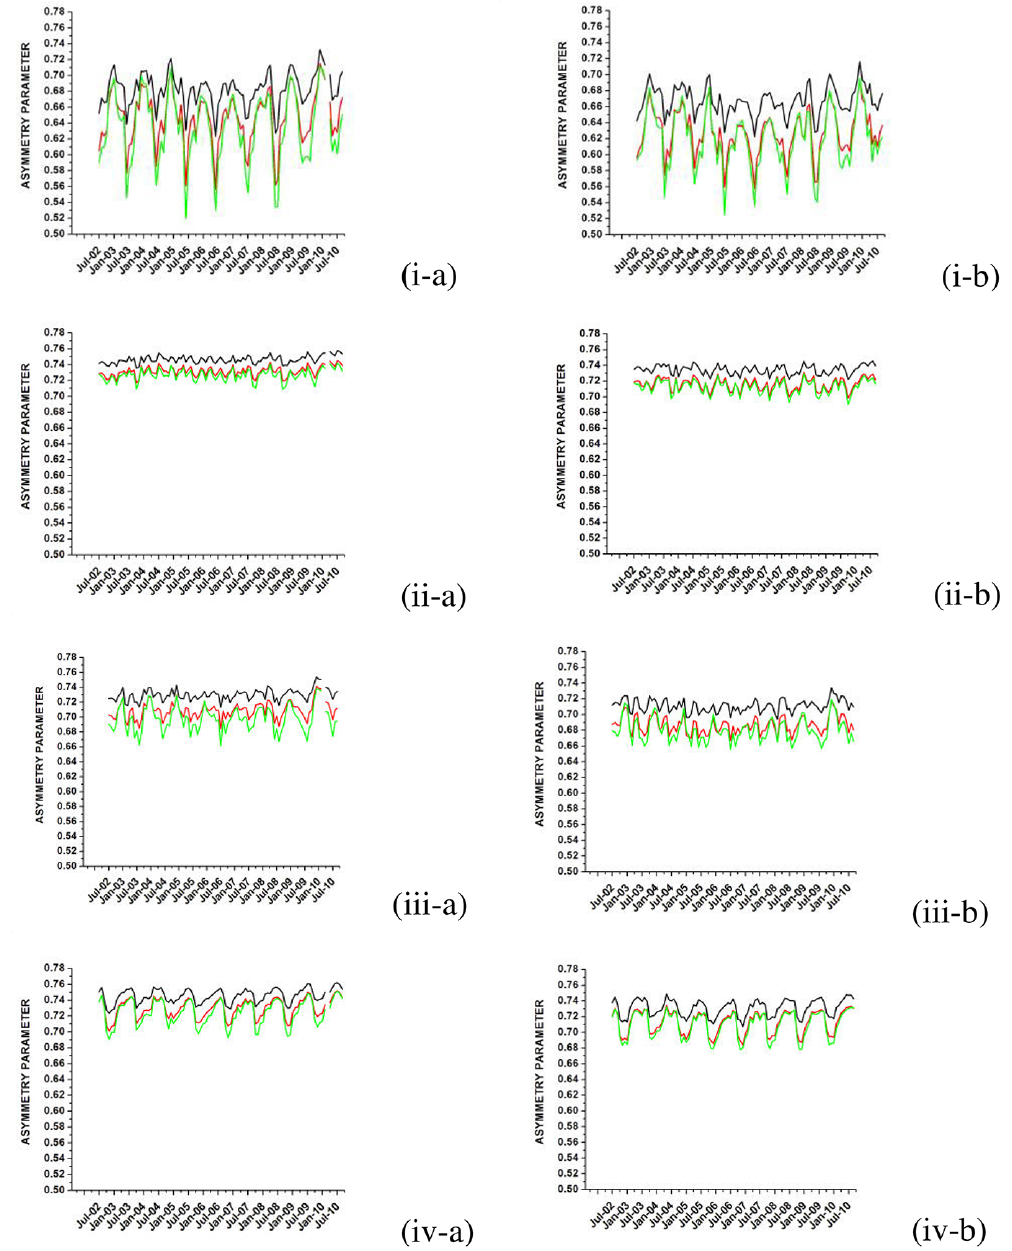
fine aerosols, the relatively high values in the Mediterranean Sea (between about 0.7 and 1.2, greenish-yellowish colors) and the low values (0.1–0.4, deep bluish colors) off the west- ern African coasts corresponding to exported Saharan dust. Over the same areas, g aer takes inverse low and high val- ues, for example smaller than 0.65 over the Black Sea and larger than 0.7–0.75 off the western African coasts (Fig. 2ii- b and iii-b), indicating the predominance of fine and coarse aerosols respectively, in accordance with AE. The